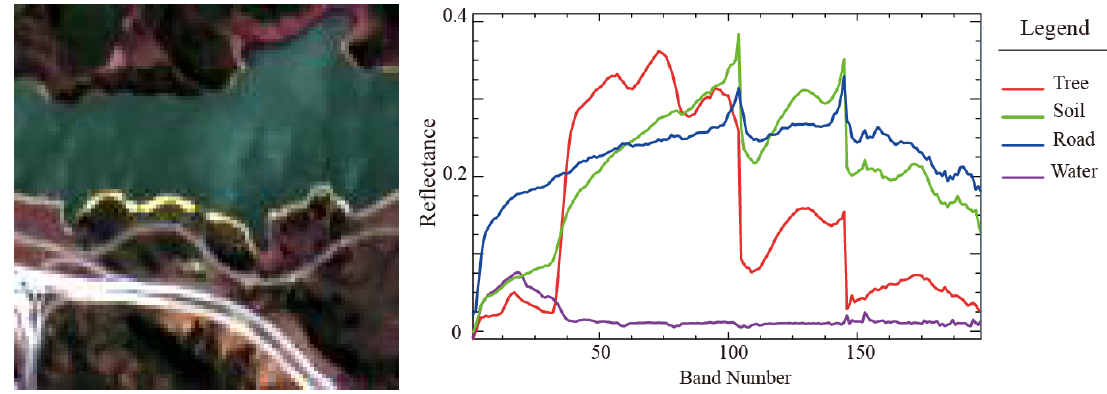
Figure 3. The Jasper Ridge data shown in RGB form and ground truth